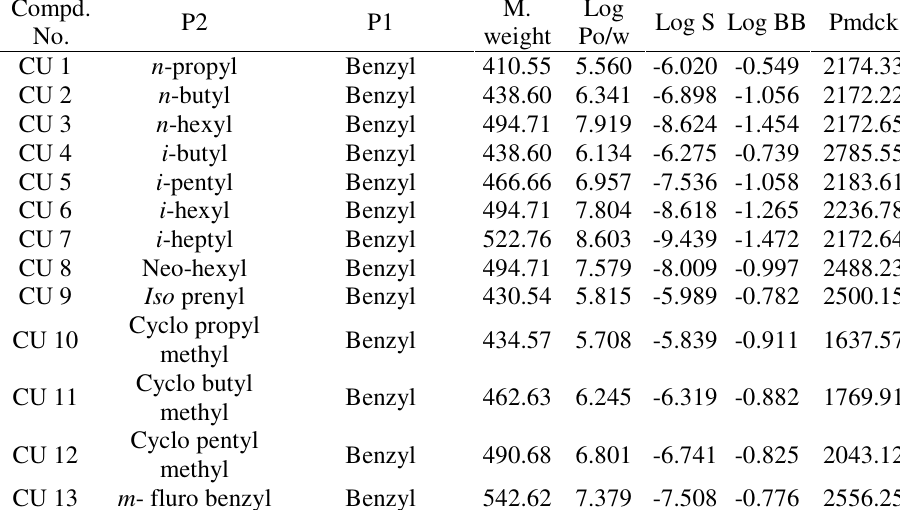
Table 1. ADME properties of cyclic urea inhibitors